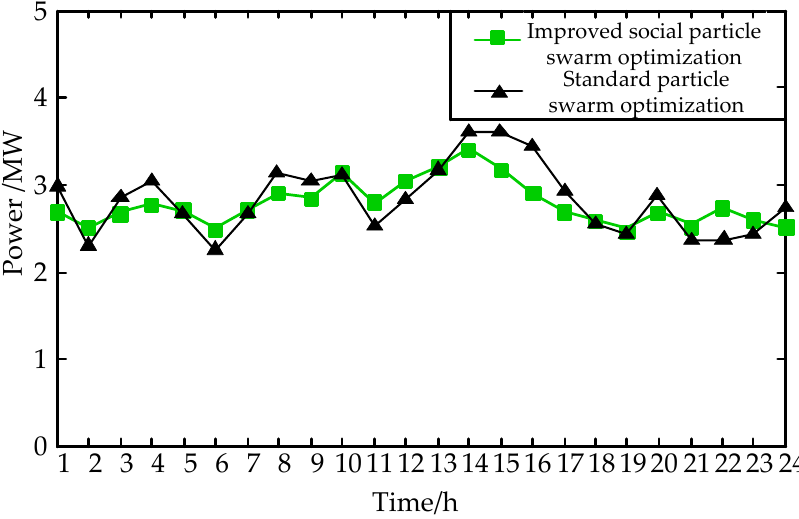
Figure 13. The comparison of the joint output curves between the two strategies on typical day B.